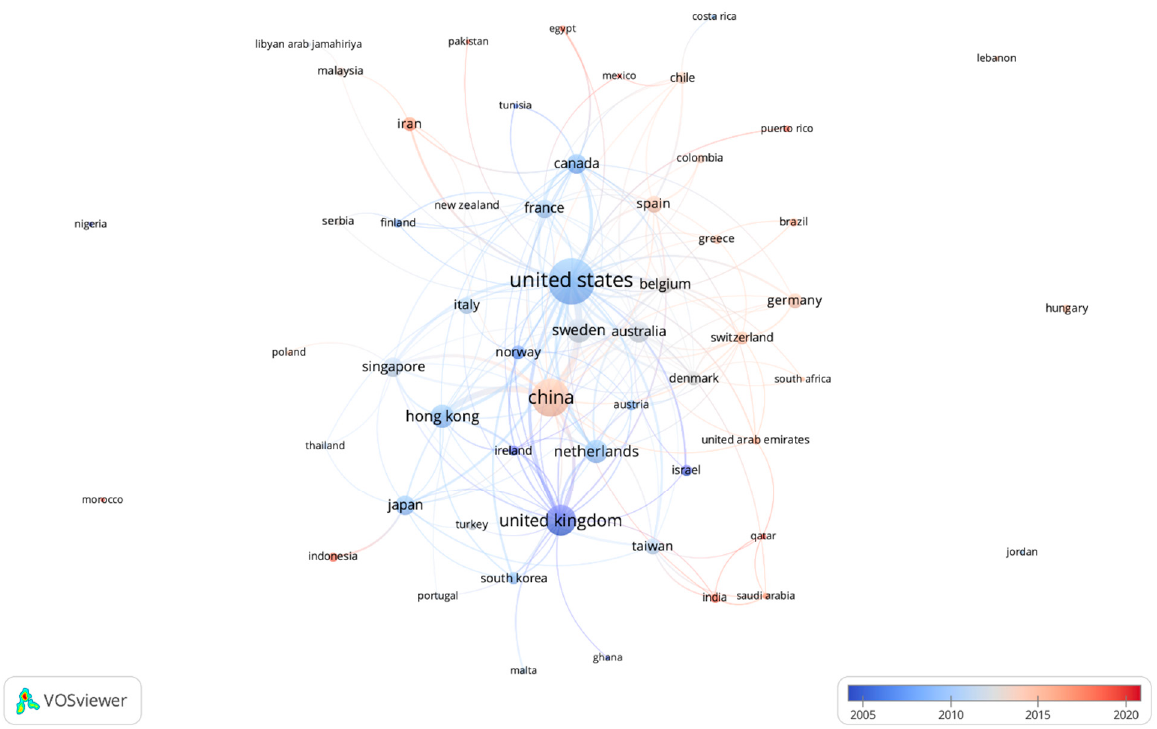
Figure 5. Country representation in congestion pricing policy research with time overlay.